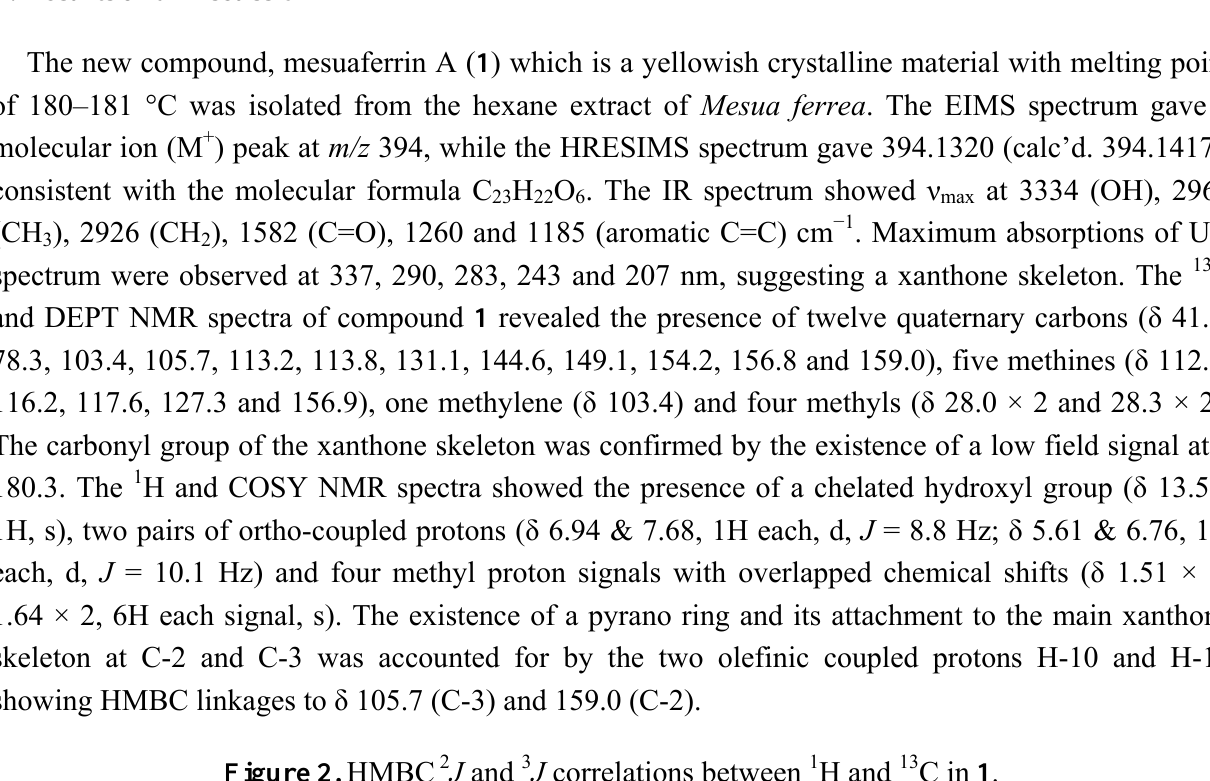
Figure 2. HMBC 2 J and 3 J correlations between 1 H and 13 C in 1